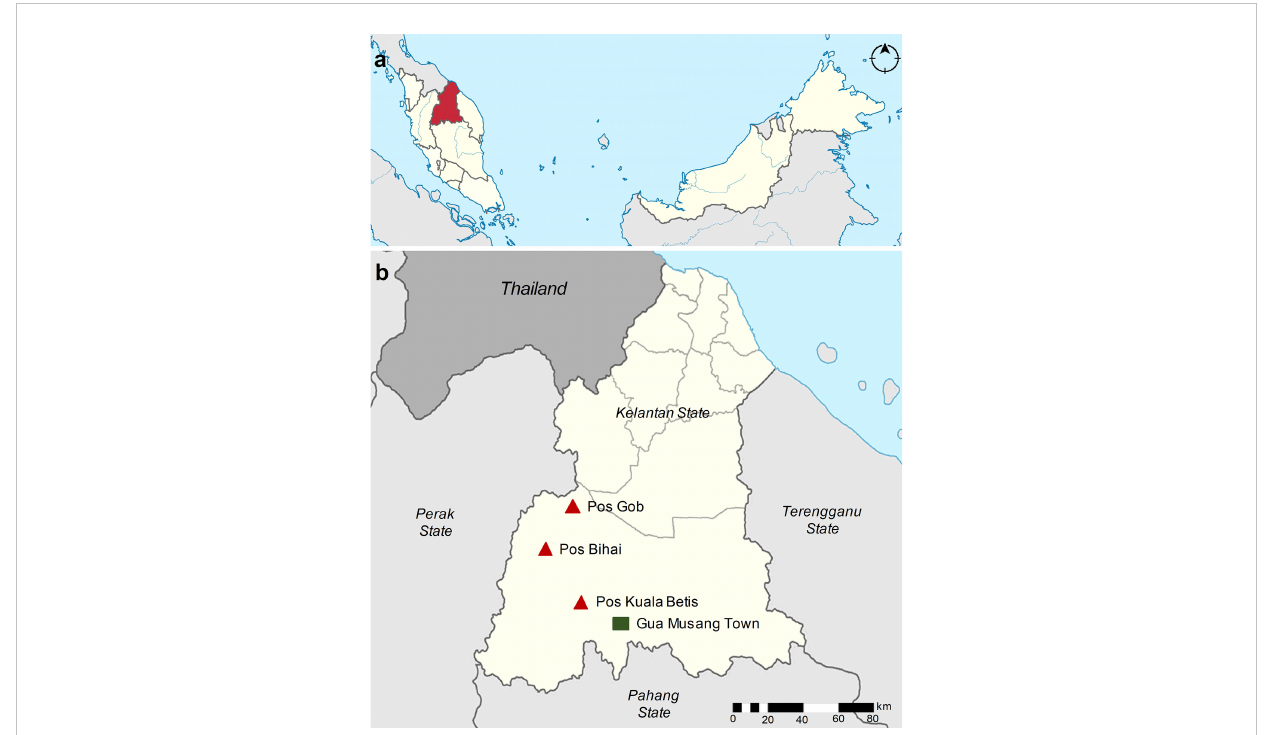
FIGURE 1 Map of the study area. (A) Map of Malaysia showing the location of Kelantan state (red). (B) The location of the three study villages is within the Gua Musang district, Kelantan state (beige). The study villages, namely, Pos Kuala Betis, Pos Bihai, and Pos Gob, are indicated in the red triangle, and the nearby town Gua Musang is indicated in the green